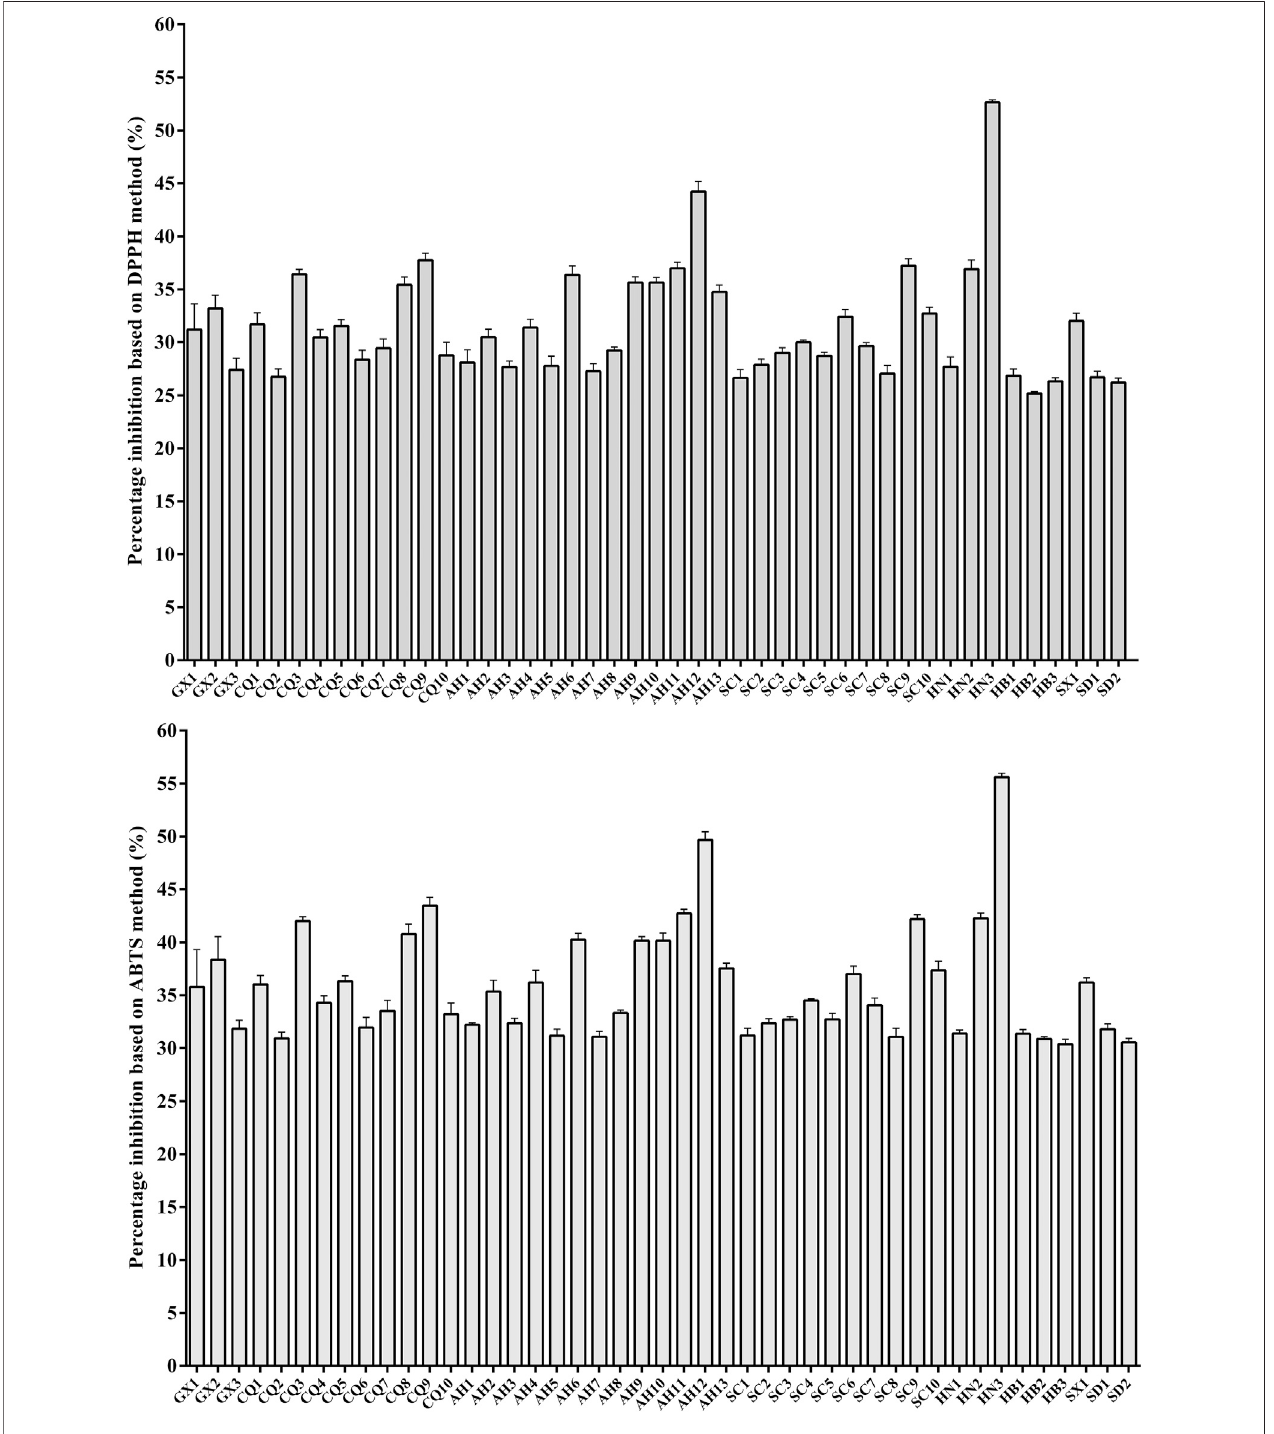
FIGURE 1 | Effect of various MC extracts on the activity of DPPH and ABTS.